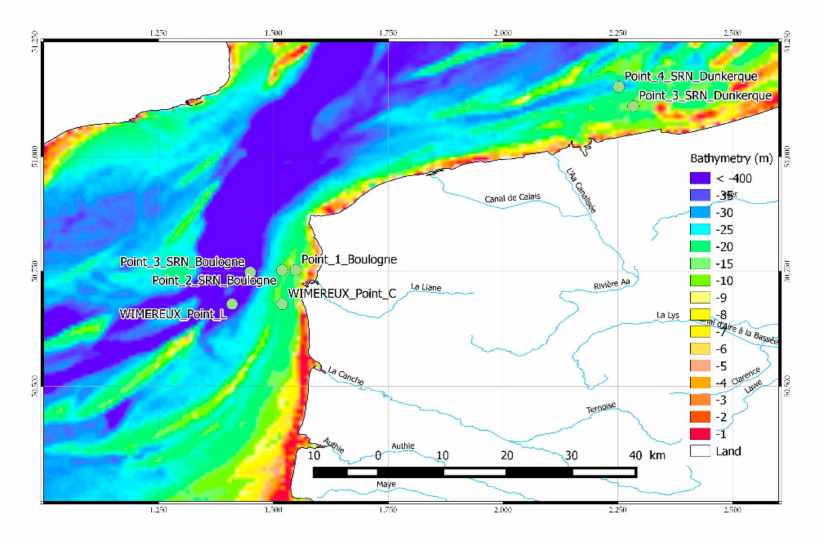
Figure 2. Zoom on the northern stations along three cross-shore transects: Dunkerque 3 and 4, Boulogne 1, 2 and 3, and Wimereux C and